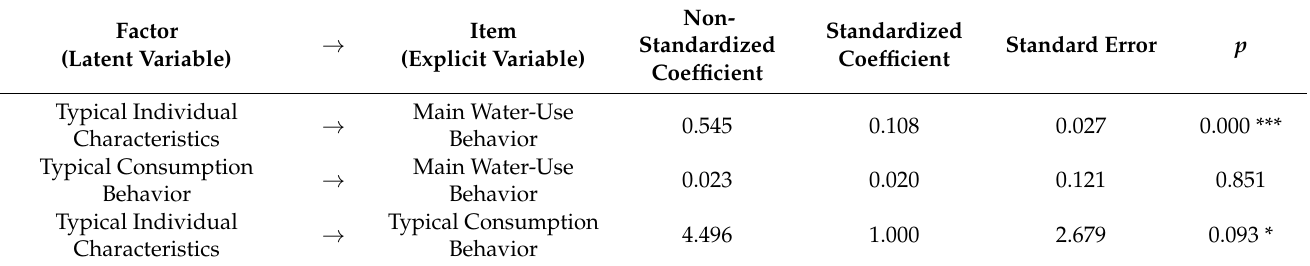
Table 5. Regression coefficient of typical water-use behavior model of hotel